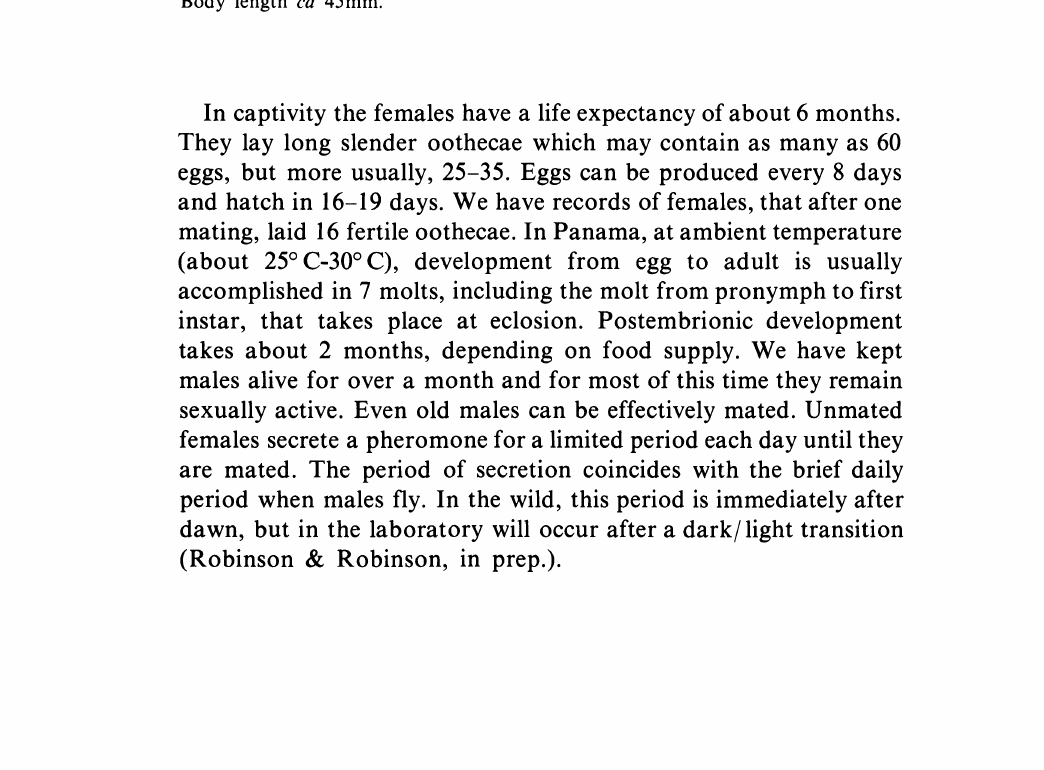
Figure 1. A female Acanthopsfalcata hanging from a twig in its cryptic posture. Body length ca